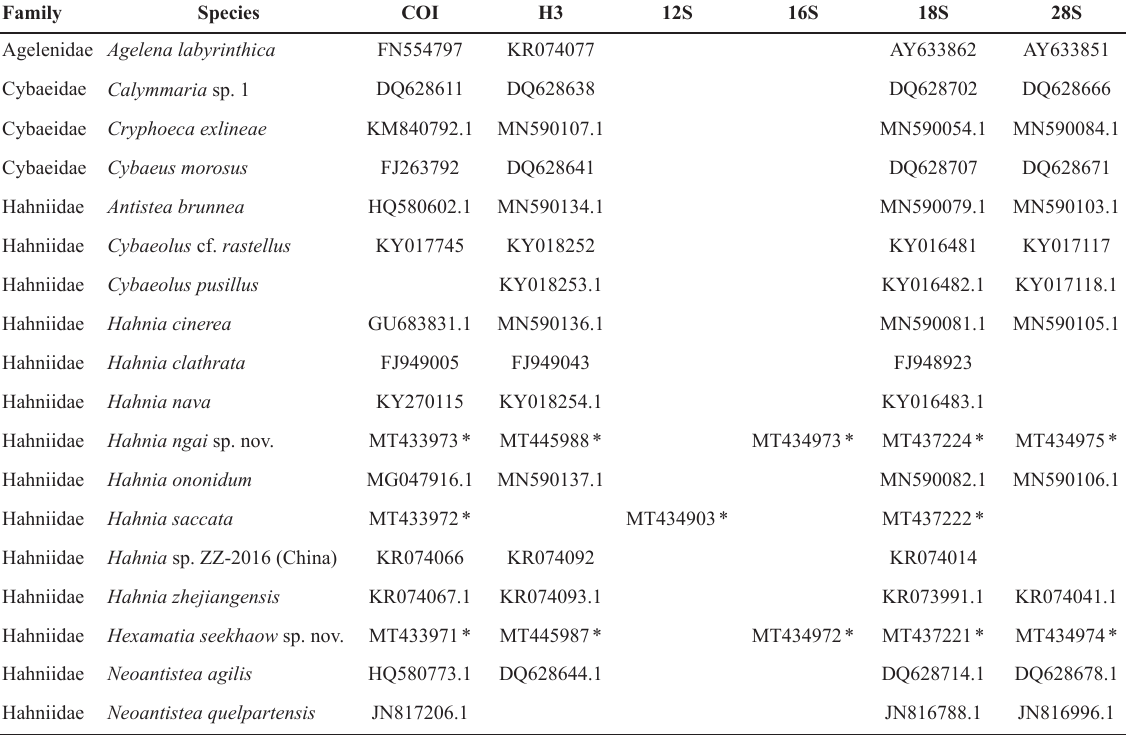
Table 1. GenBank accession numbers of DNA sequences used for our analyses. * marks the new sequences generated for the present